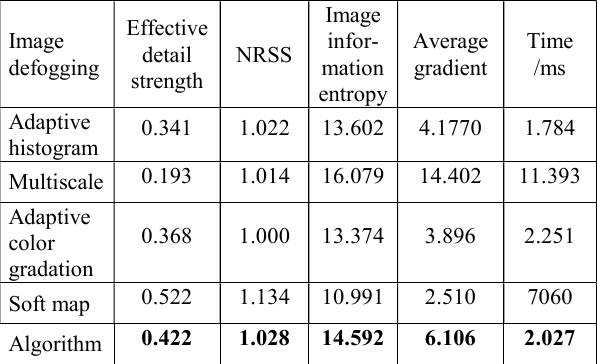
Table 1. Objective evaluation indicators for different